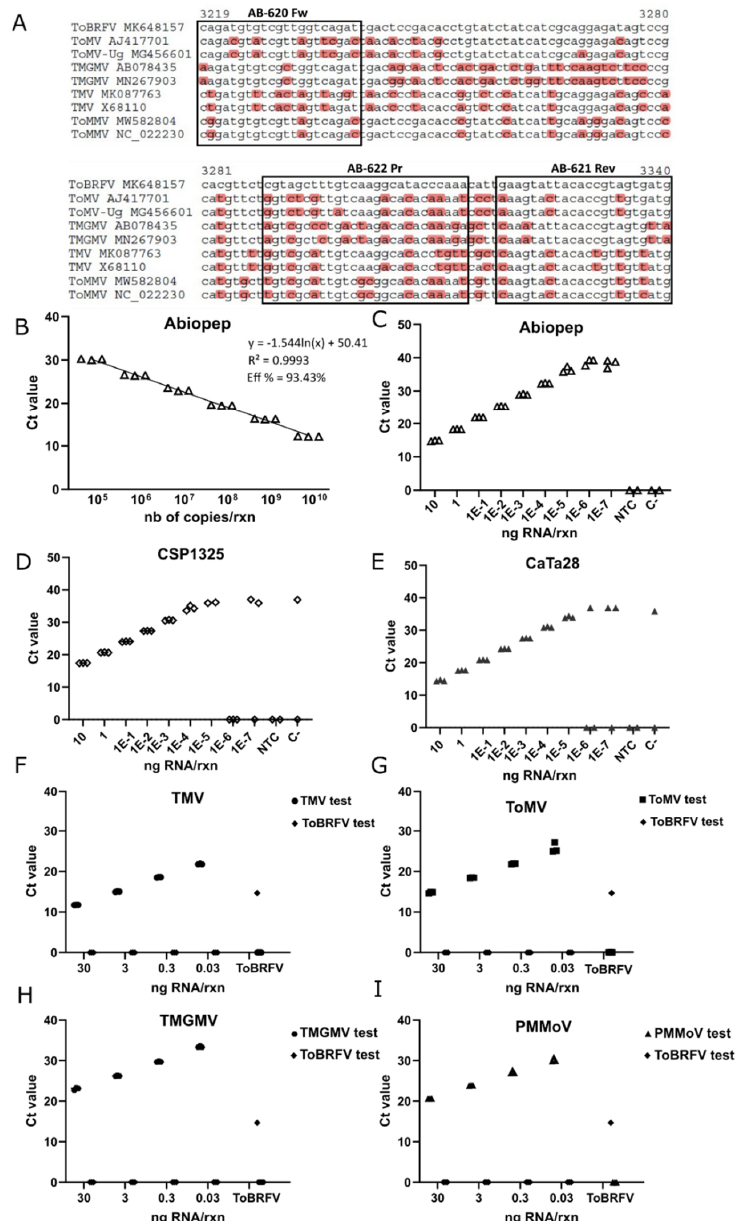
Figure 3. Design and evaluation of an RT-qPCR test for the detection of the ToBRFV RdRP . ( A ) Alignment of the large fragment of the ToBRFV RdRP 3 ′ end and other closely related tobamoviruses to examine the exclusivity of the oligonucleotides. Mismatches are shown in red and the selected oligonucleotides (AB-620 Fwd, AB-621 Rev, and AB-622 Pr) are indicated with rectangles. We have given the name of “Abiopep” to this set of oligonucleotides. The NCBI accession numbers for each virus sequence are shown together with the virus acronym. ( B ) Assessment of the Abiopep test sensitivity using serial dilutions of a synthetic transcript of an RdRP fragment. The Ct values versus the number of copies per reaction are plotted. ( C – E ) Evaluation of the analytical sensitivity of Abiopep, CaTa28 and CSP1325 tests using serial dilutions of total RNA extracted from tomato leaves infected with ToBRFV. ( F – I ) Analytical specificity of the Abiopep test checked using dilutions of RNA extracted from infected N. benthamiana leaves with related tobamoviruses. Each RNA extract was assessed with both a specific set of oligonucleotides designed for the amplification of that virus in particular (TMV (F), ToMV (G), TMGMV (H), or PMMoV(I)), and with the Abiopep test. As a positive control, ToBRFV RNA was used. For all the graphs, Ct values from three technical replicates are represented versus the nanograms of RNA per reaction (rxn). NTC and healthy plant RNA extract (WT) were used as negative controls. All the dilutions were made using a healthy plant RNA extract as diluent. Experiments in (B) and (C) were repeated three times.